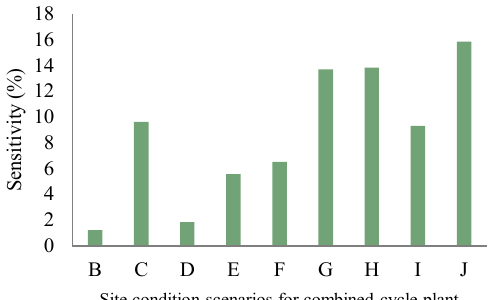
Fig. 8: Sensitivity of carbon footprint to group 3 scenarios for combined cycle plant